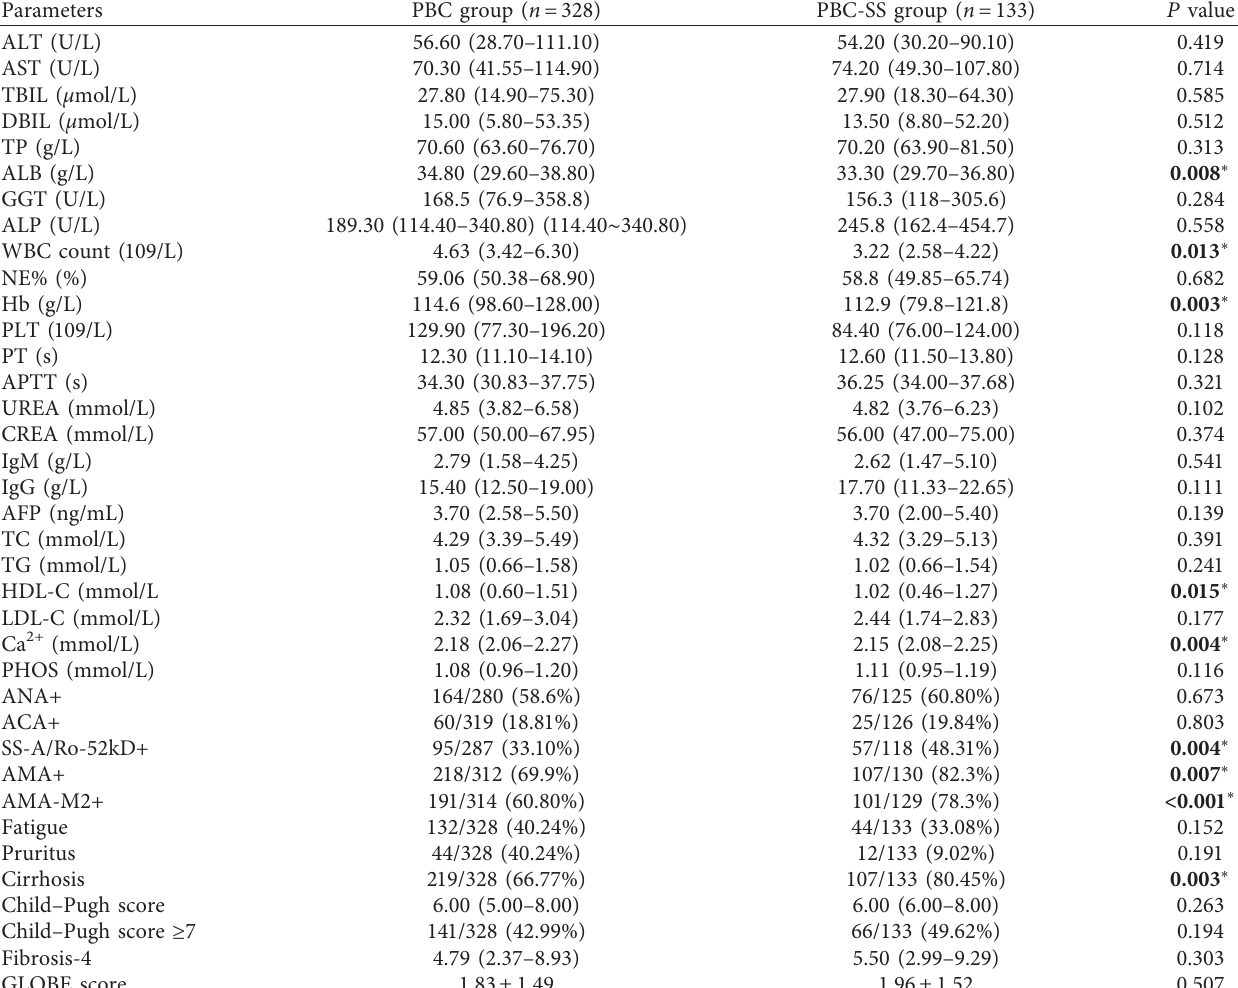
Table 2: Clinical features and laboratory results of patients with primary biliary cholangitis and those with primary biliary cholangitis complicated with Sj¨ogren’s